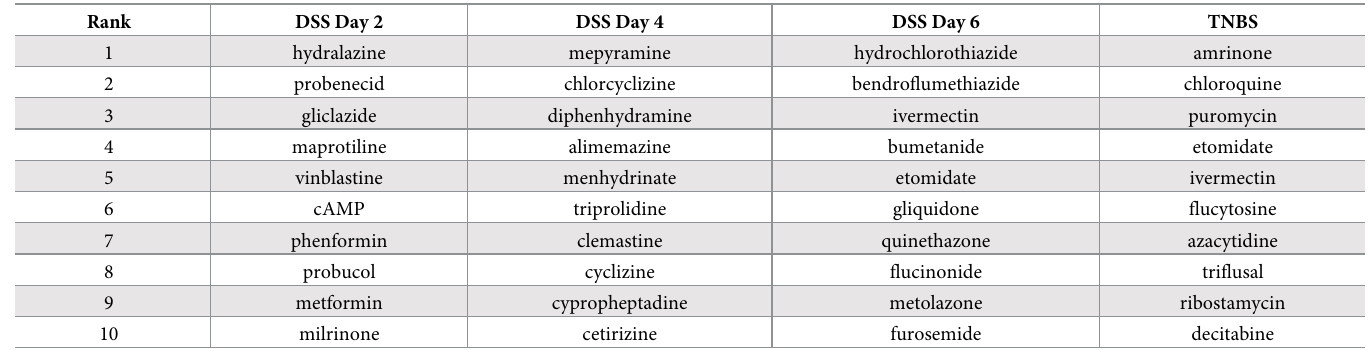
Table 4. Overall average drug rankings for DSS and TNBS mouse colonic samples.